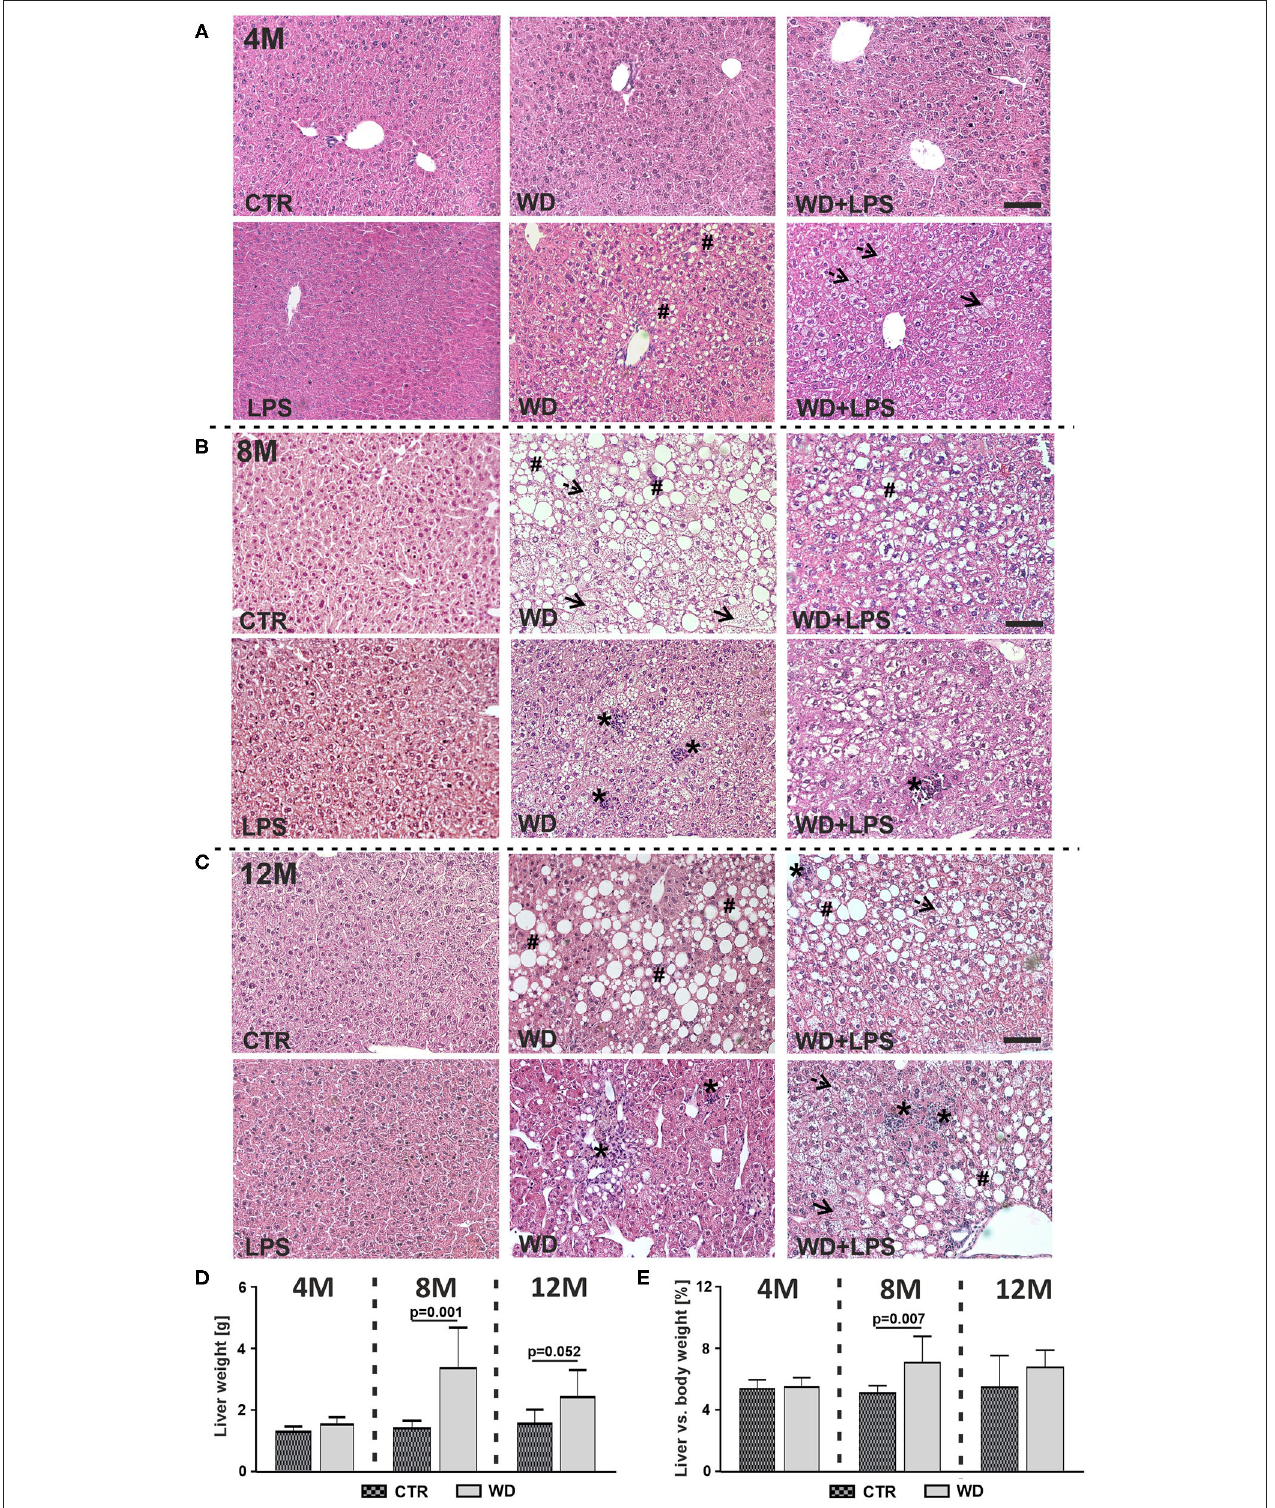
FIGURE 2 | Western diet induces non-alcoholic fatty liver disease (NAFLD) and non-alcoholic steatohepatitis (NASH). Microscopic images of hematoxylin-eosin histological staining of liver tissue from (A) 4-month-old APPswe mice fed with WD for 3 weeks, (B) 8-month-old APPswe mice fed with WD for 5 months,